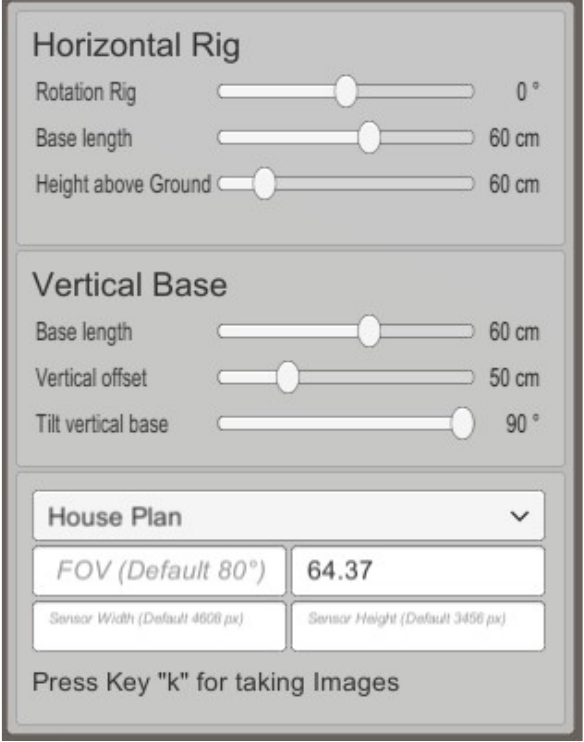
Figure 3. Camera rig with configuration panel (right)